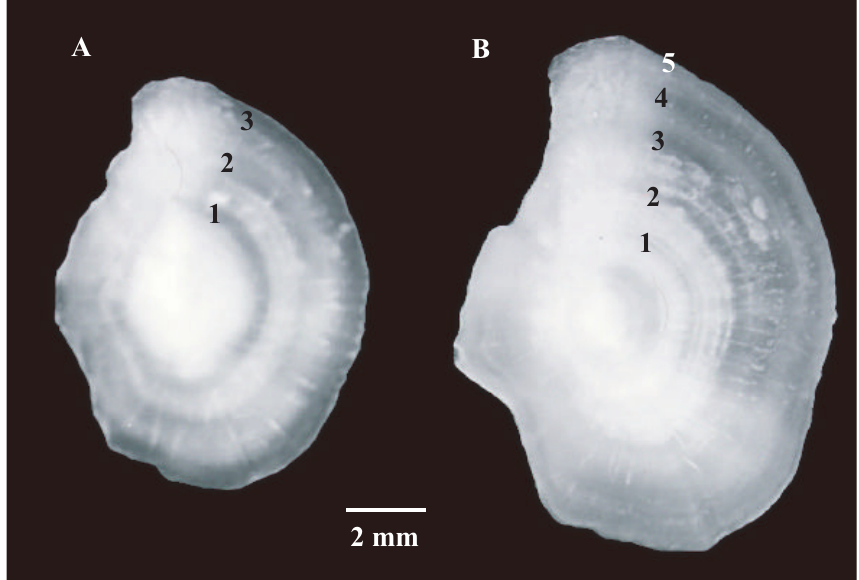
F IG . 3. – Saggital otoliths of P. incisus off the Canary Islands. (A), a three years old (202 mm), (B) five years old (265